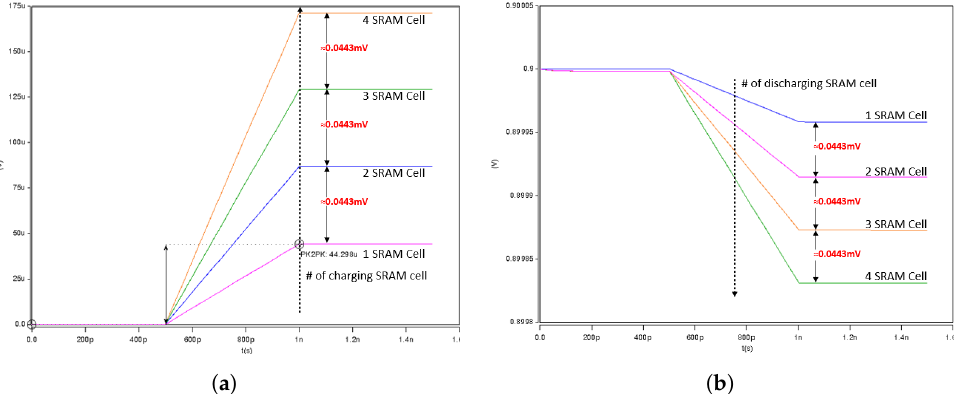
Figure 5. Charging or Discharging range with 4 × SRAM bitcells. ( a ) Charge range for up to +4 result. ( b ) Discharge range for up to − 4 result.